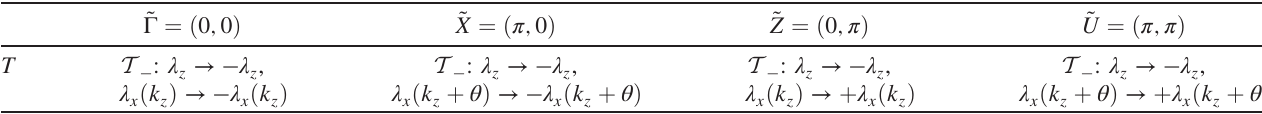
− k ; k ∥ modulo a reciprocal x z Þ ¼ in Eq. (11), only (cid:2) ∈ ½ − π ; π (cid:5) ; k ∥ Þ for generic k ∥ .